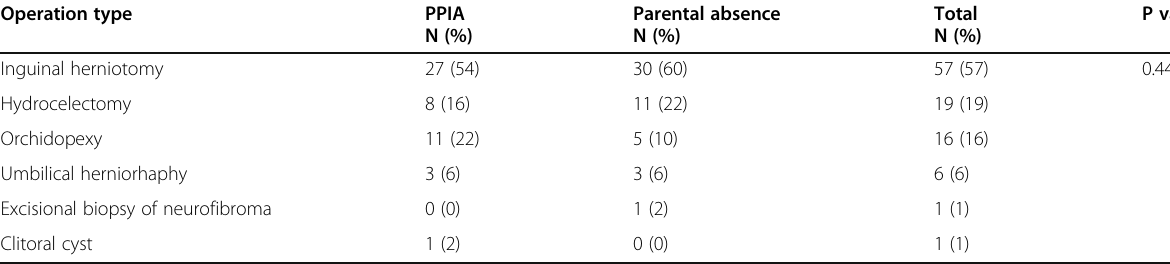
Table 2 Type of operation performed among participating children Operation